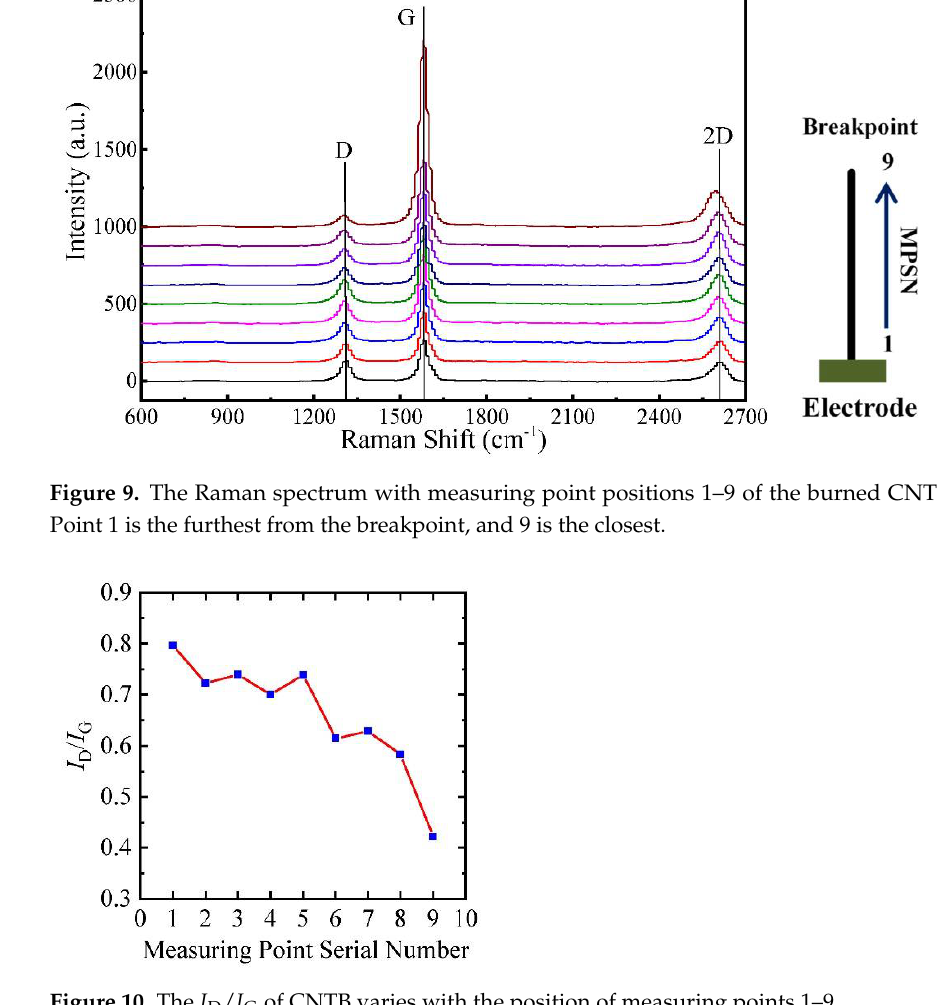
Figure 10. The I D / I G of CNTB varies with the position of measuring points 1–9.